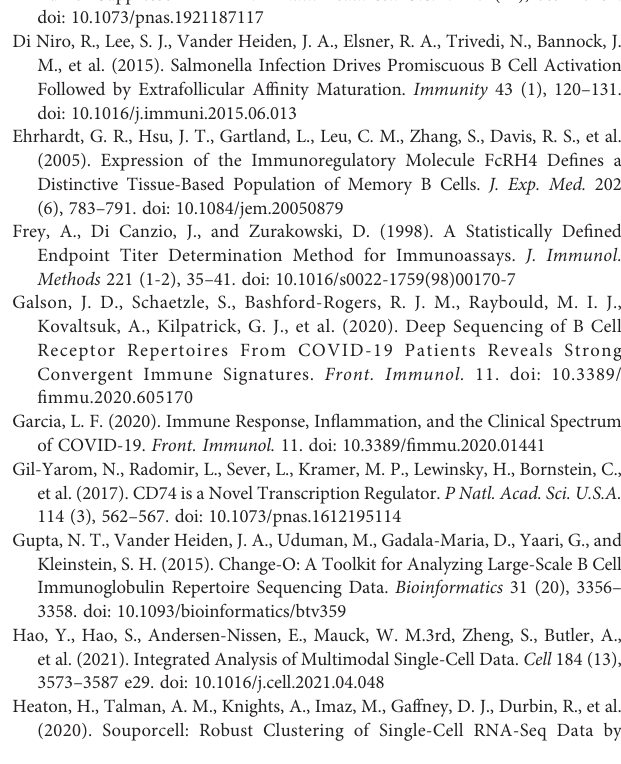
Supplementary Figure 3 | Cellular distribution of B cells from individual patient on trajectory UMAP of naïve and memory B cells (see ).